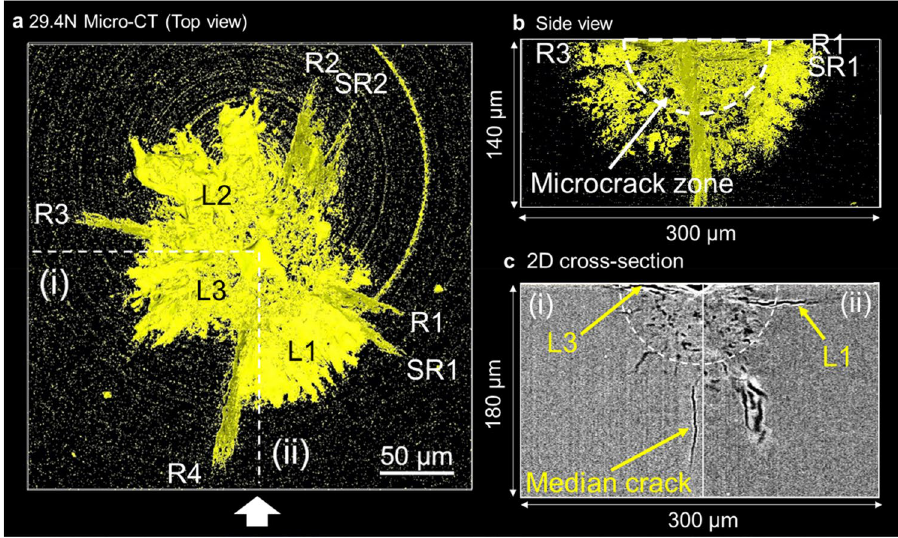
Figure 2. Micro-CT observation of Vickers indentation cracks at 29.4 N load. ( a ) Top view, ( b ) side view, ( c ) 2D cross-sectional image along white dashed lines (i) and (ii) in ( a